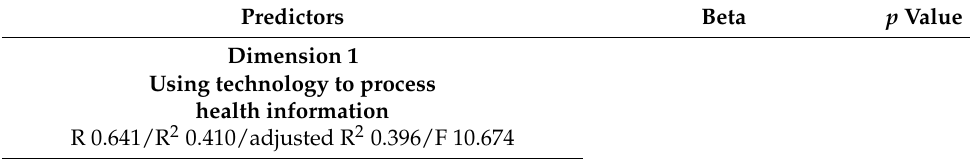
Table 2. Multiple regression model for eHealth